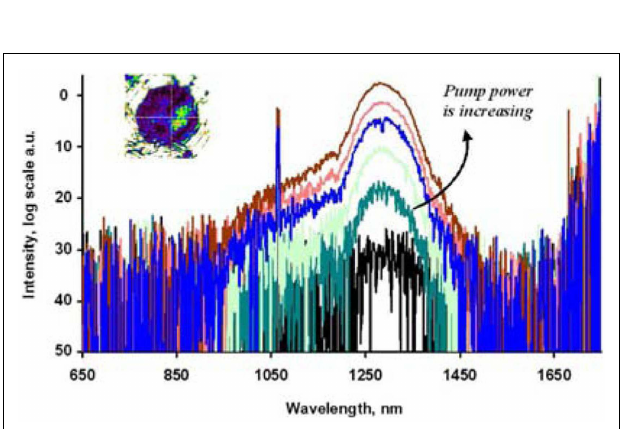
FIGURE 20 | Evolution of the spectra recorded at the output of the PbSe QDs liquid-core fiber for varying input power . Inset: near field pattern recorded at the output of the fiber (Hreibi et al., 2010).